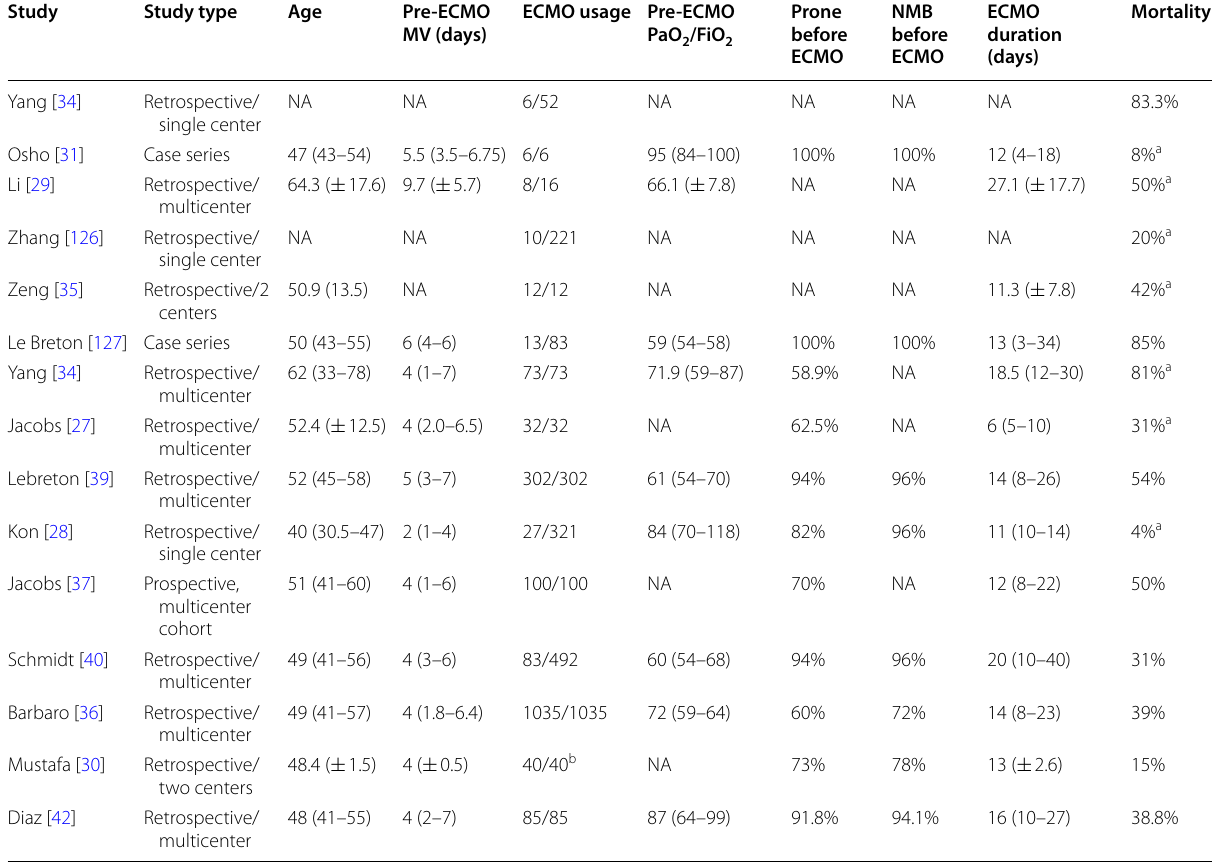
Table 2 Studies reporting outcomes of veno-venous ECMO in COVID-19 critically ill